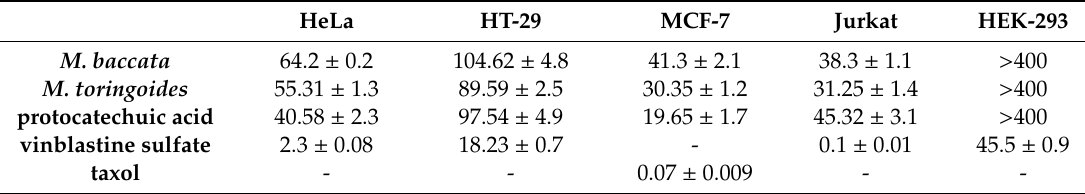
Table 3. Antiproliferative activity [IC 50 ( µ g mL − 1 )] of Malus baccata and Malus toringoides bark extracts, ( µ g mL − 1 ) as well as protocatechuic acid, on cancer cells. Values are the means of 3